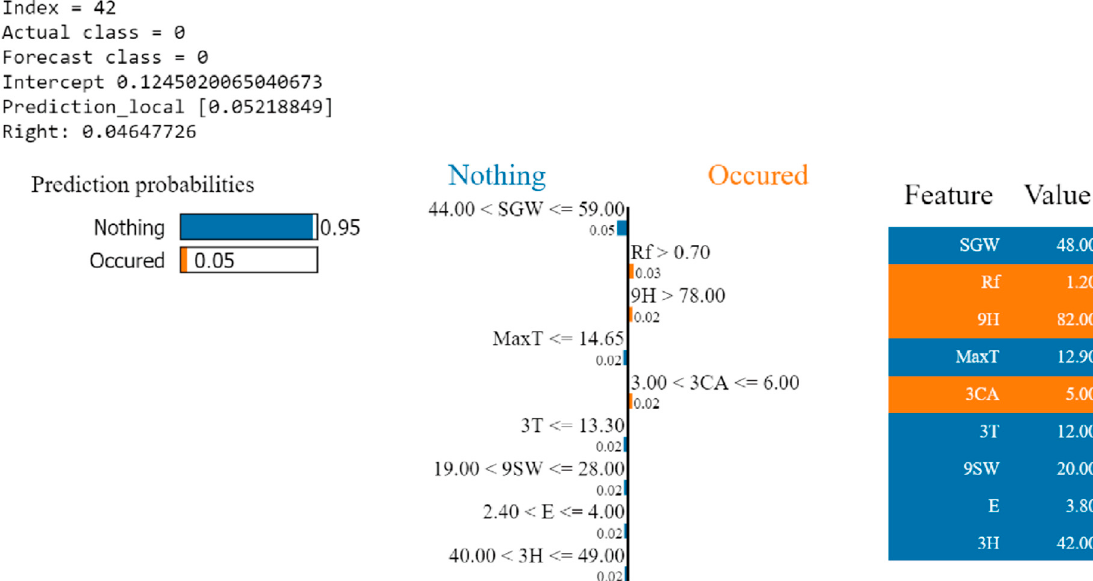
Figure 13. LIME explanation for a sample No. 42.